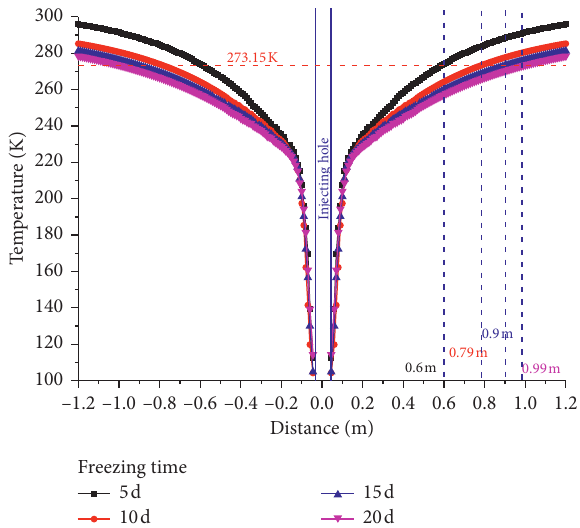
Figure 9: Temperature curves of coal seam in ( x ) direction at different freezing